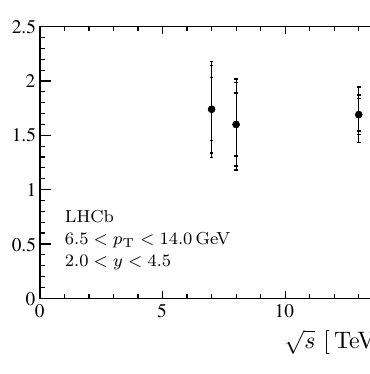
Fig. 2 The prompt η c production cross-section as a function of centre- of-mass energy. (Left) Relative η c prompt production cross-section. (Right) Absolute η c (black rectangles) and J /ψ (blue circles) prompt